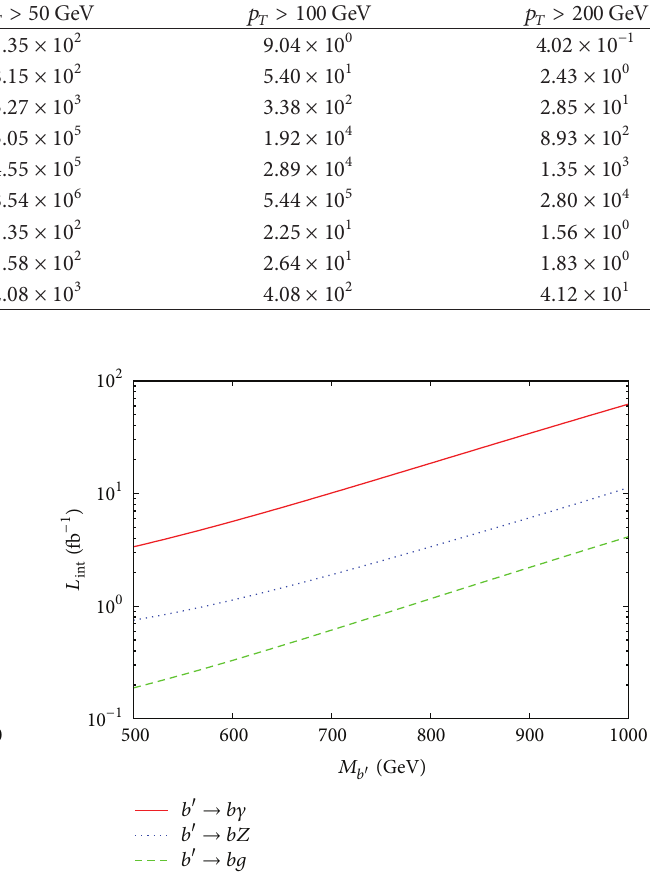
Figure 13: Integrated luminosity required to reach 3𝜎 significance for the signal of 𝑏 󸀠 anomalous interactions for parametrization PI at the LHC with √𝑠 = 13 TeV.